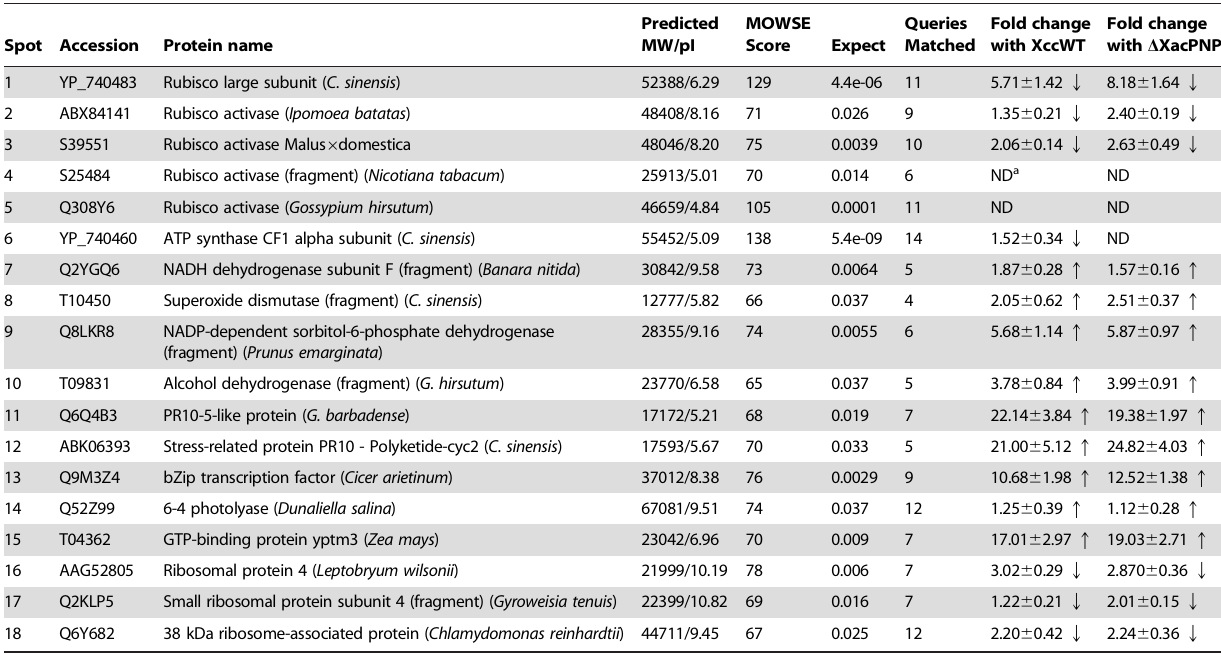
Summary of the differentially expressed proteins identified from citrus leaf tissue infected with Xcc wild type and D XacPNP Fold change of protein levels relative to mock infiltrated leaves were quantified and the results for 6 dpi are shown. a ND: not detected.